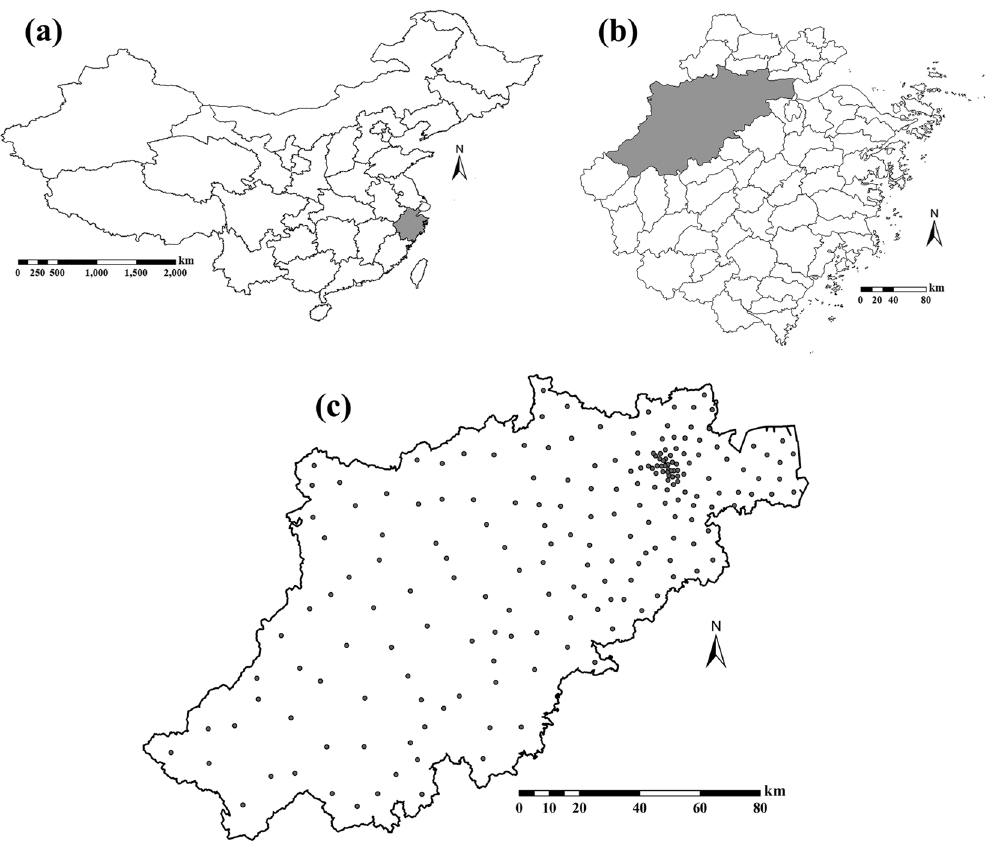
Figure 1. BC incidence data locations in Hangzhou city during the period 2008–2012. ( a ) Chinese provinces boundaries; ( b ) city boundaries in Zhejiang province; ( c ) Hangzhou city and BC incidence locations. Maps were carried out with ArcGIS 9.3. URL link: